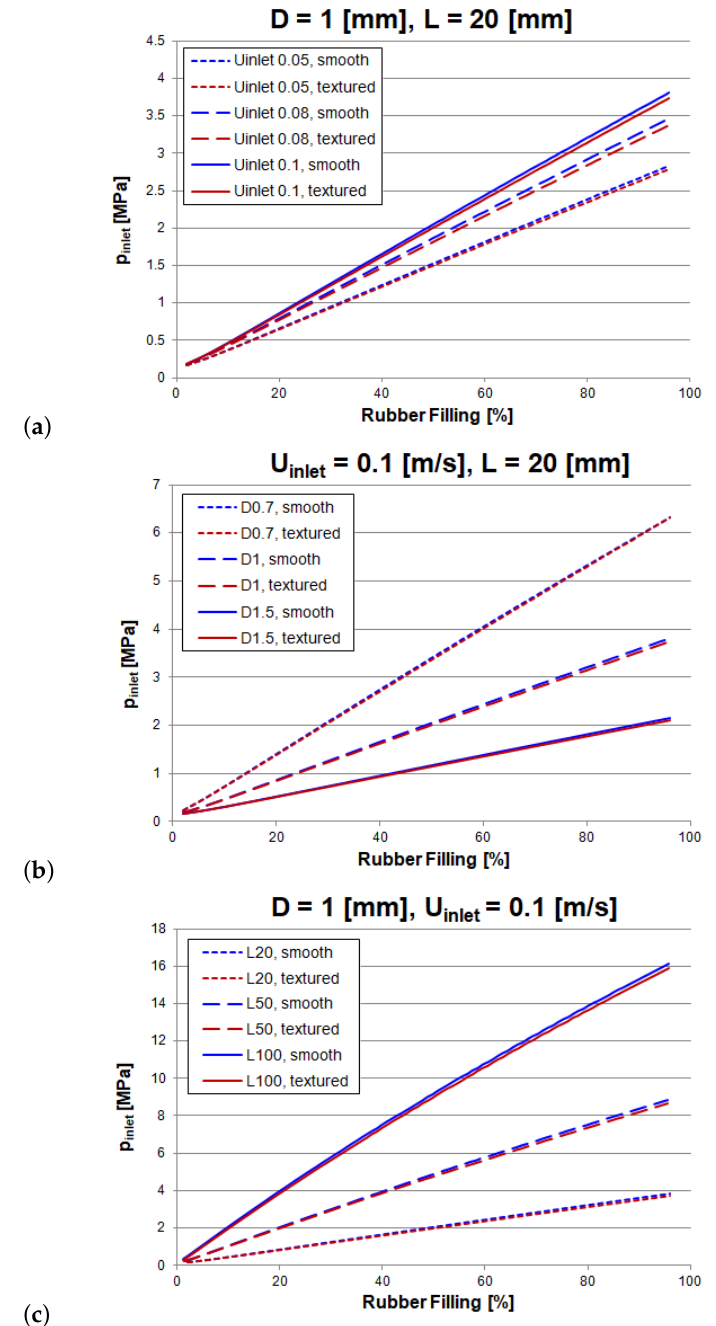
Figure 8. Results of the filling of a straight pipe (smooth vs textured wall): ( a ) influence of inlet velocity; ( b ) influence of diameter; ( c ) influence of